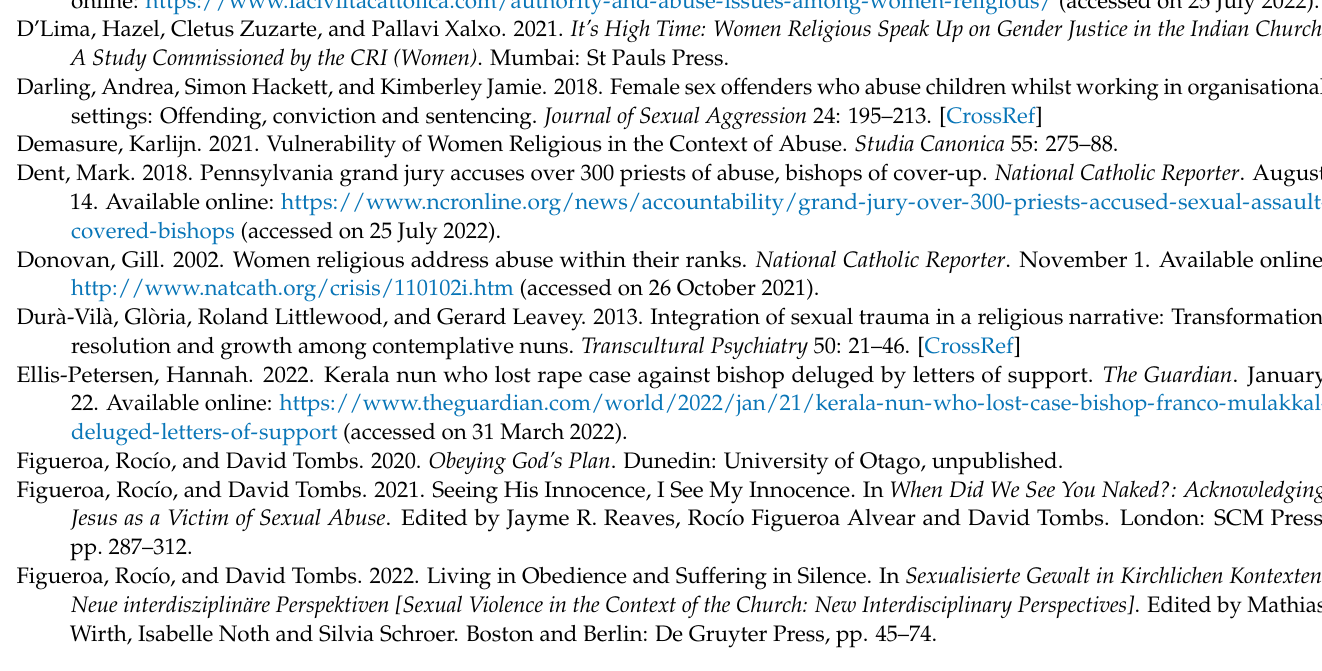
Figueroa, Roc í o, and David Tombs. 2020. Obeying God’s Plan . Dunedin: University of Otago, unpublished. Figueroa, Roc í o, and David Tombs. 2021. Seeing His Innocence, I See My Innocence. In When Did We See You Naked?: Acknowledging Jesus as a Victim of Sexual Abuse . Edited by Jayme R. Reaves, Roc í o Figueroa Alvear and David Tombs. London: SCM Press, pp. 287–312. Figueroa, Roc í o, and David Tombs. 2022. Living in Obedience and Suffering in Silence. In Sexualisierte Gewalt in Kirchlichen